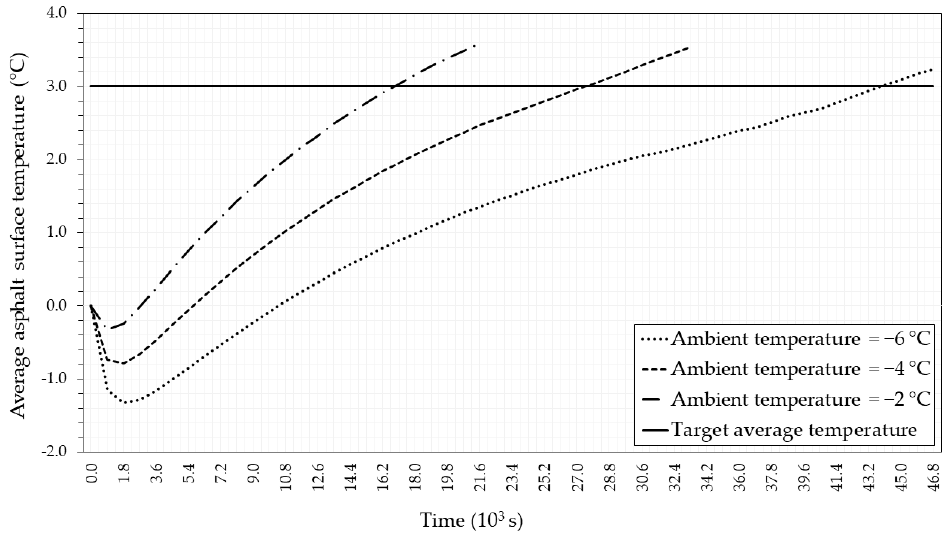
Figure 10. Time interval required to reach and maintain an average temperature of 3 °C at the as- phalt surface with initialization at 0 °C.